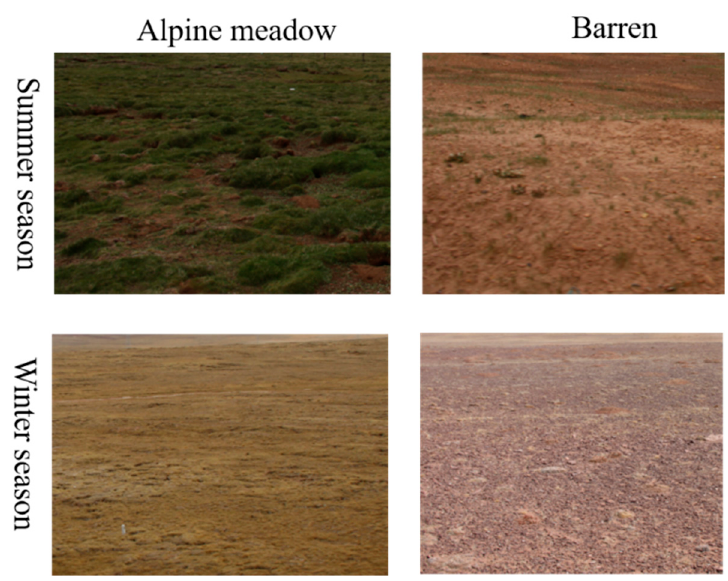
Figure 2. Field photos of typical land covers of the study site in summer and winter seasons.